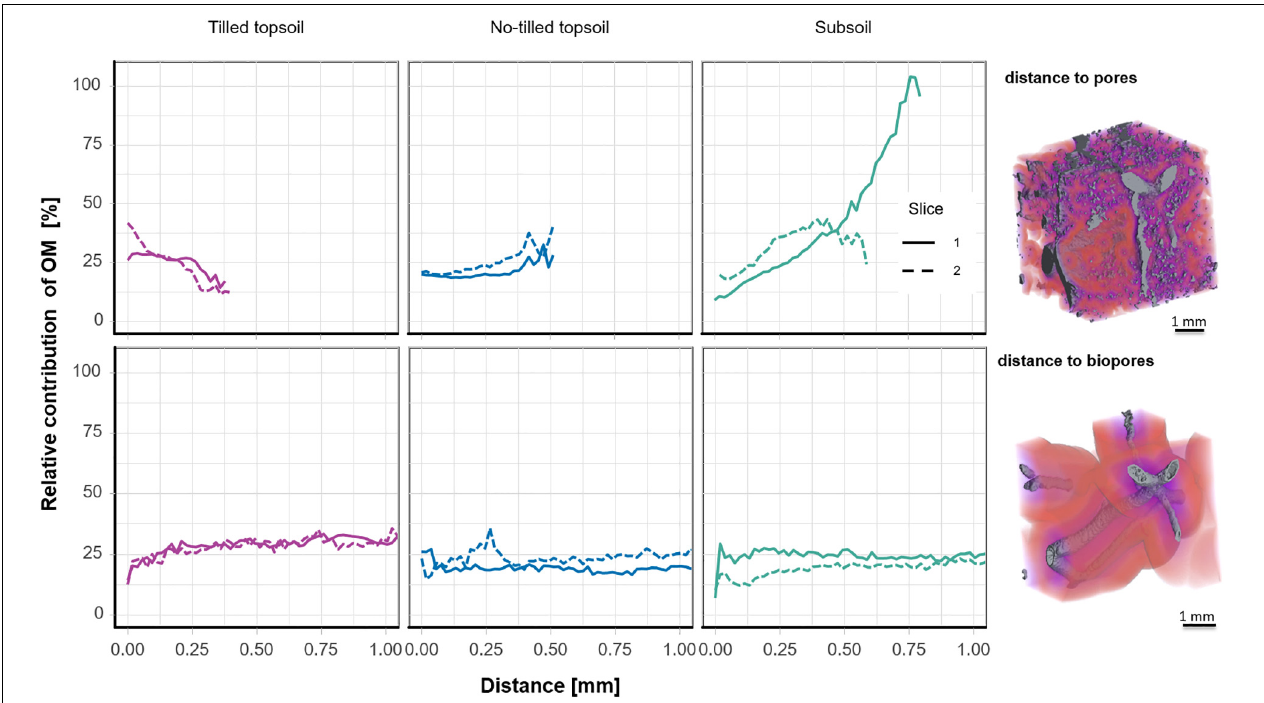
FIGURE 5 | Area based relative contribution of OM in linear spectral unmixing images with the 3D Euclidean distance to pores (upper graphs) and biopores (bottom graphs). The pictures on the right display the same cutout of macropores and biopores (gray) and the corresponding distances (small distance = purple, high distance =